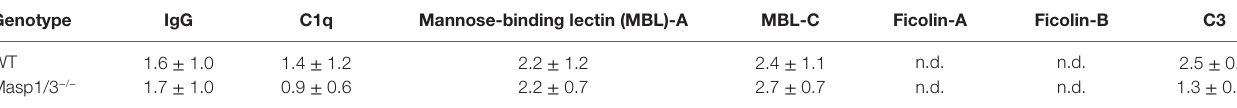
TaBle 1 | Scores for glomerular deposition of IgG and complement in 24-week-old MRL/ lpr mice.